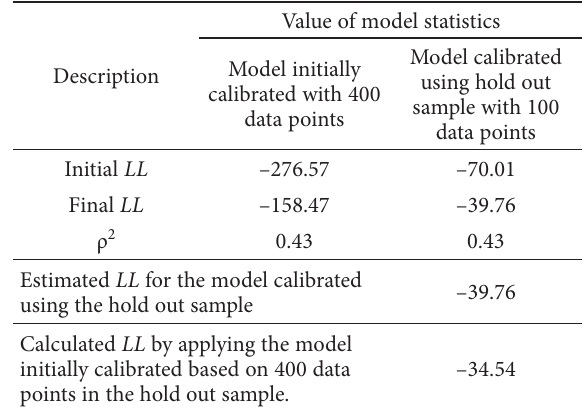
Table value of t , @ 2.5% level of significance, =